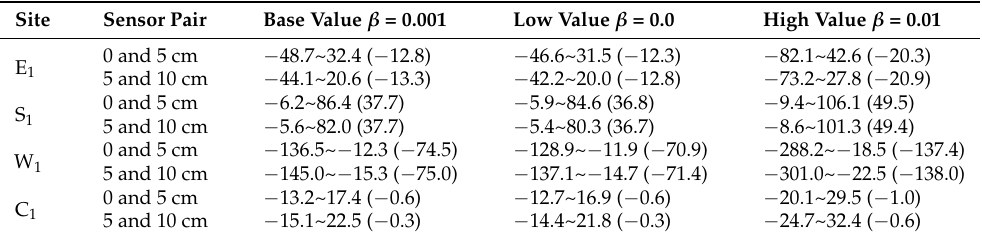
Table 1. Sensitivity analysis for thermal dispersivity ( β , m) on the estimated flux (mm d − 1 ) ranges and mean values (in parentheses) at sites E 1 (potentially alternative downwelling and upwelling), S 1 (downwelling), W 1 (upwelling), and C 1 (almost static flow) of Lake